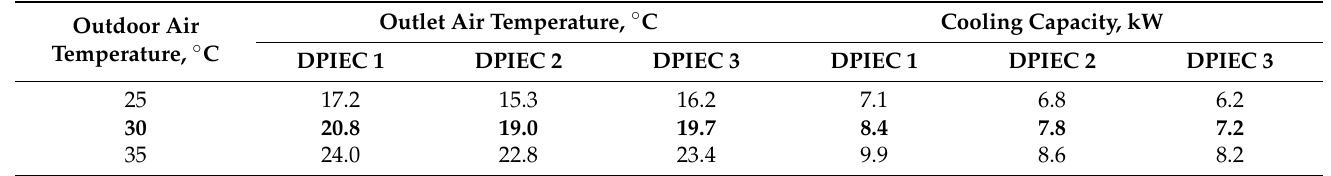
Table 4. The results of exchanger comparison for outdoor air relative humidity RH =